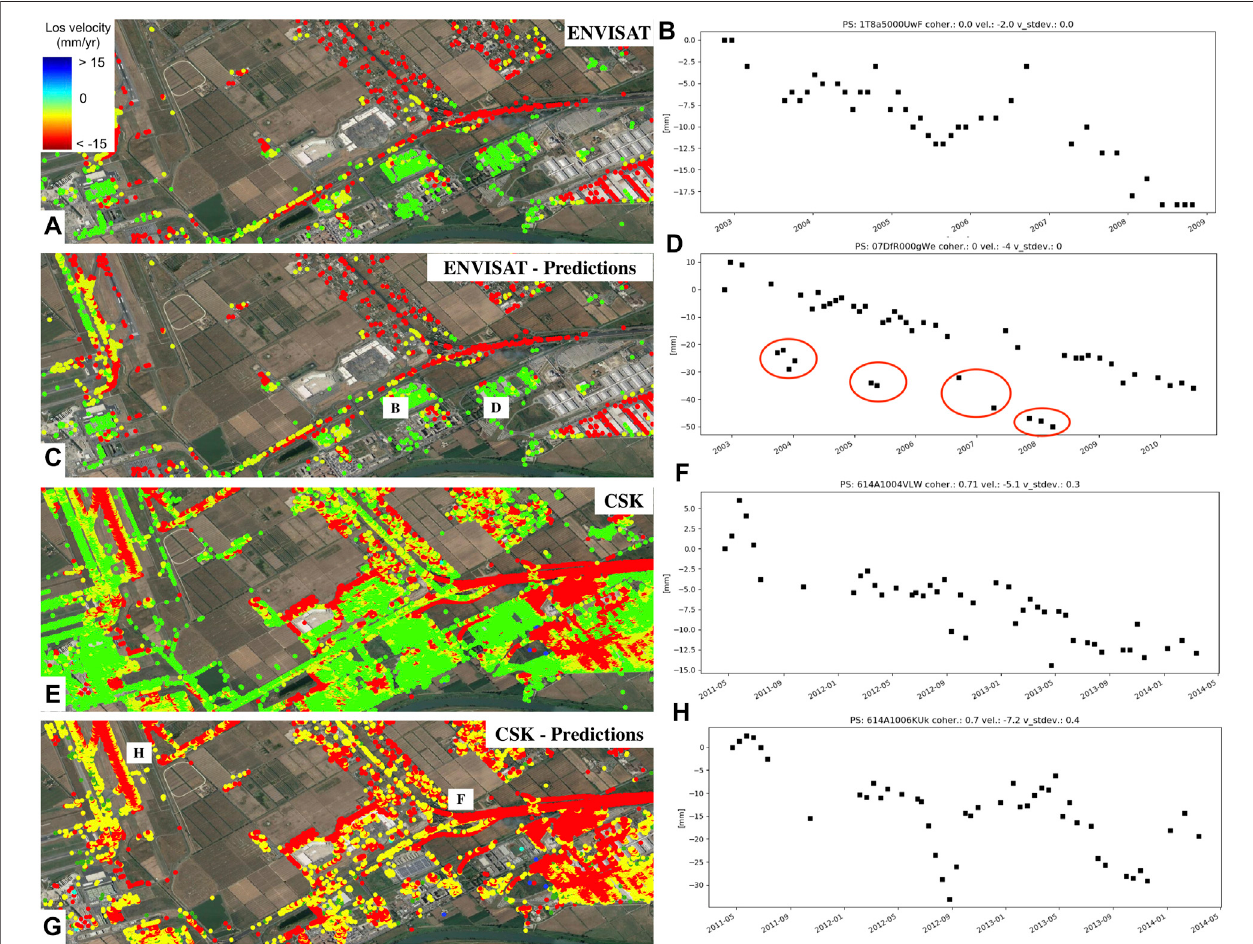
FIGURE 5 | Examples of multi-temporal time-series dataset as observed by different sensors: (A) Envisat dataset over the Rome airport. (B) Time series of an anomalous point located over a building moving at – 2 mm/year. (C) Envisat dataset Neural Network signals covering the period 2003 – 2009. Letters B and D represent thelocationofthetimeseriesshowninpanels (B) and (D) . (D) Anomaloustimeseriesmovingatanaveragerateof − 4 mm/year.Theredcirclesindicatepointsinthetime series potentially affected by unwrapping errors that in this case have been detected as anomalies. (E) CSK dataset over the Rome airport spanning the period 2011 – 2014. (F) TimeseriesofananomalouspointlocatedoverthehighwayshowingananomalousbehaviorbetweenMayandJuly2011. (G) Timeseriesofanomalous pointsoftheCSKdatasetpredictedassignalsbytheneuralnetworkapproachpresentedinthispaper.LettersFandHrepresentthelocationofthetimeseriesshownin panels (F) and (H) . (H) Timeseriesofdisplacement related toanareacharacterizedbyananomalousdeformationpattern(linearand seasonal) neartheairportrunaway. Further details on the displacement fi elds characterizing this area can be found in Bianchini Ciampoli et al. (2020).